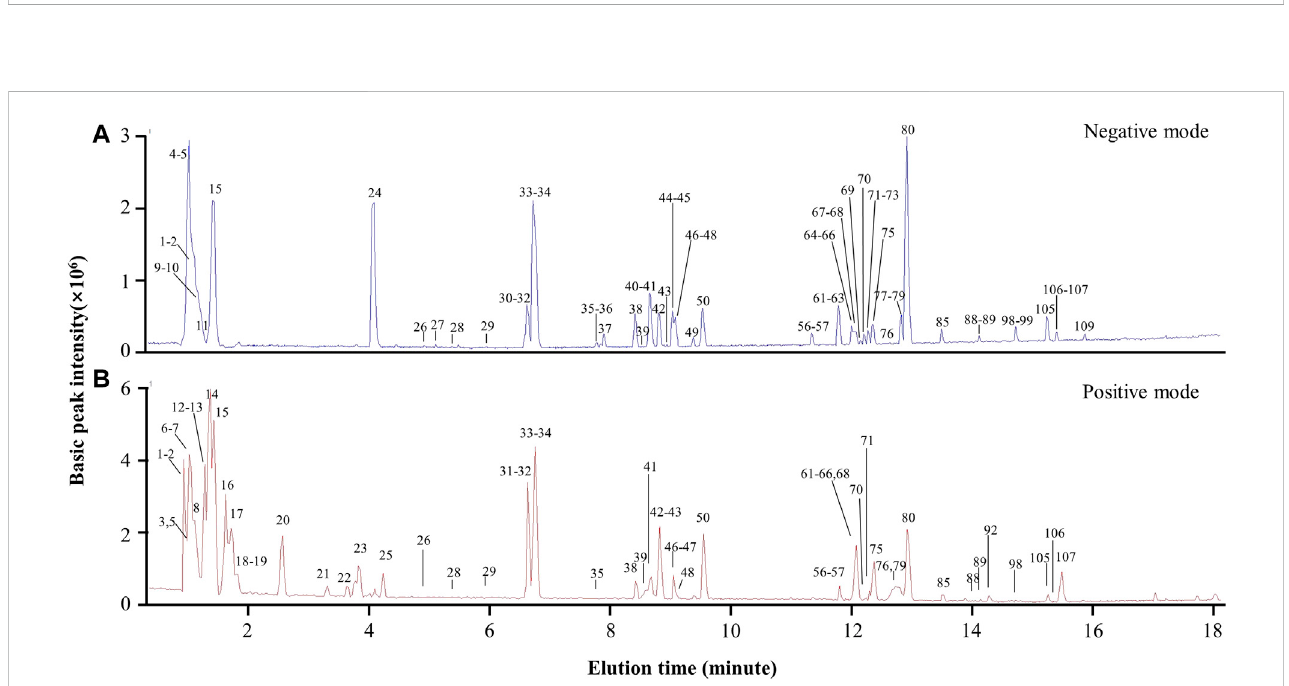
FIGURE 4 UPLC-MS/MS pro fi ling of the preparation BYDE. (A) Base peak chromatogram (negative mode) of the preparation BYDE. Major peaks of BYDE were shown. (B) Base peak chromatogram (positive mode) of the preparation BYDE. The peaks were detected by Agilent 6,540 Ultra High De fi nition (UHD) Accurate-Mass Q-TOF LC/MS and numbered in order according to the retention